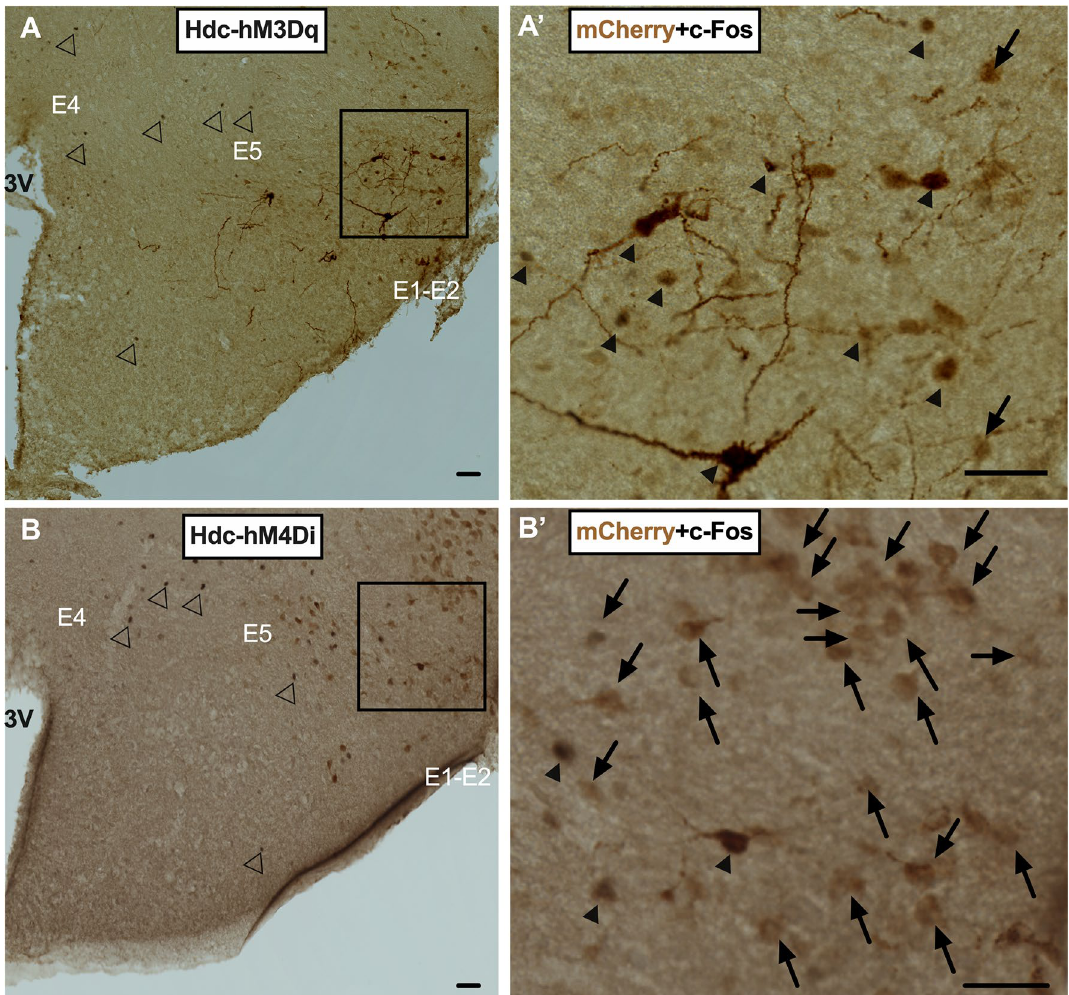
Figure 1. Specific expression of Hdc-hM3Dq/Hdc-hM4Di in the TMN and confirmation of neuronal activation or inhibition by CNO. ( A ) A representative hypothalamic section from an Hdc-Cre mouse injected with AAV-hM3Dq. CNO injection induced c-Fos expression (black nuclei) in mCherry-expressing HA TMN neurons (brown) ( A ′ ). ( B ) Representative section from an Hdc-Cre mouse injected with AAV-hM4Di. c-Fos expression (black) was substantially lower in mCherry-positive neurons (brown) after CNO injection ( B ′ ). Scale bar = 200 μm. 3 V, third ventricle; E1-2 and E4-5, neuronal clusters of HA TMN . Arrows: mCherry-positive/c-Fos- negative neurons, Black arrow heads: mCherry-positive/c-Fos-positive neurons, White arrow heads: mCherry- negative/c-Fos-positive neurons. These coronal brain sections were located − 2.18 mm anterior–posterior from